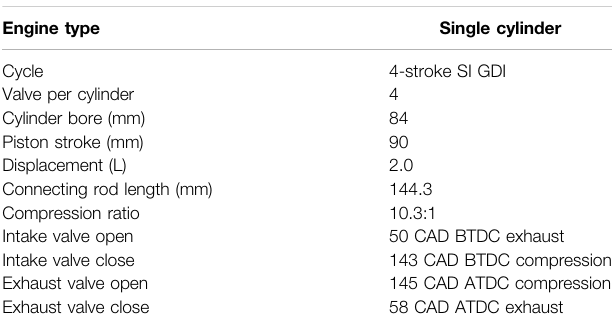
TABLE 1 | Engine speci fi